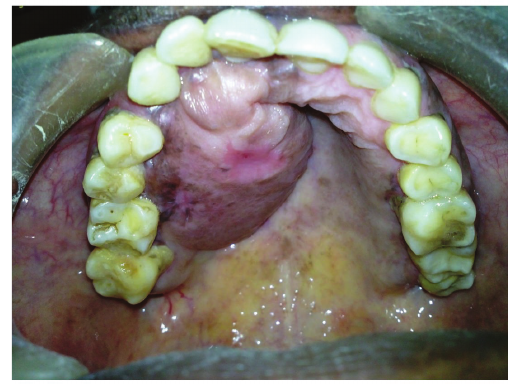
Figure 2: Solitary, oval, well-defined palatal swelling.